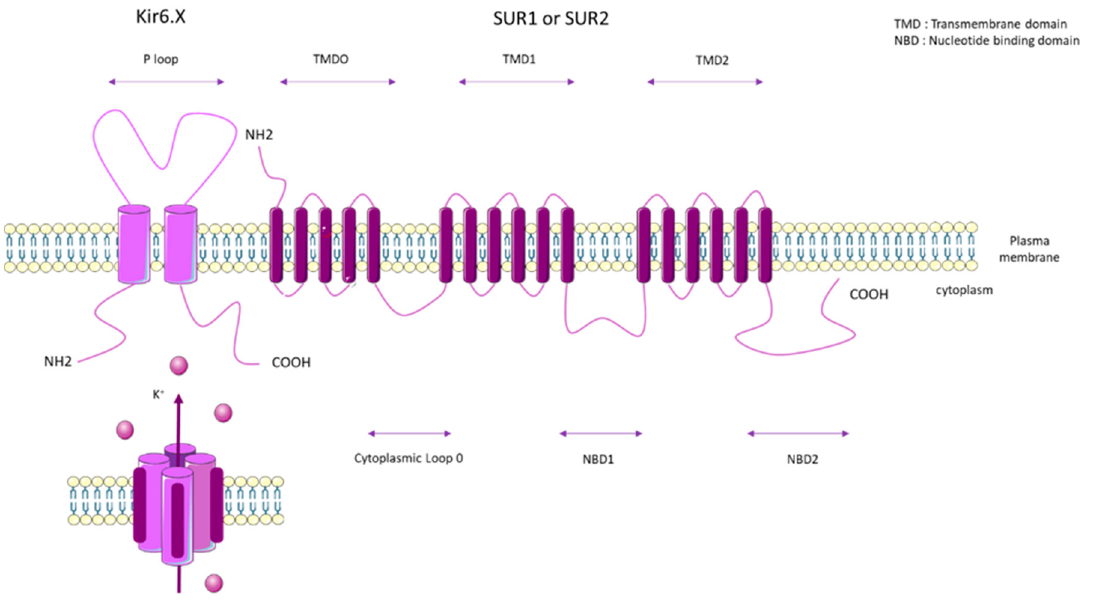
Figure 4. General molecular architecture of ATP-sensitive potassium channels (KATP) channels. The KATP form in a hetero-octameric conformation is composed of four inward-rectifier-K + channel subunits (Kir6.x), which represent the pore forming subunits, and four regulatory subunits (Sur.x, sulfonylurea receptor). There are two types of Kir 6.x subunits (Kir6.1 and Kir6.2) and two types of KATP subunits co-assemble in di ff erent manners, depending on the tissue type. TMD: Transmembrane Sur.x subunits (SUR1 and SUR2), and there are two splice variants of SUR2 (SUR2A and SUR2B). domain. NBD: Nucleotide binding KATP subunits co-assemble in different manners, depending on the tissue type. TMD: Transmembrane domain. NBD: Nucleotide binding domain.